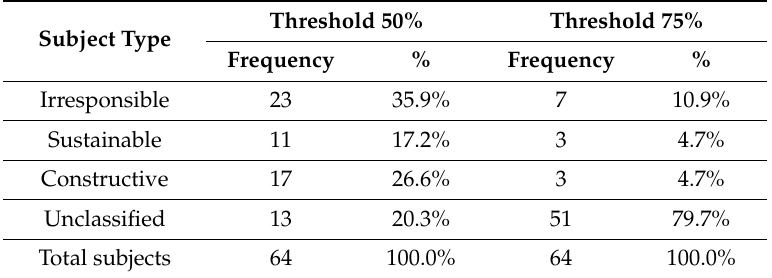
Table 2. Distribution of subject types using different thresholds of